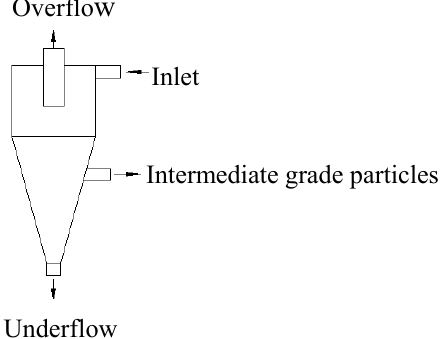
Figure 4. Three-product cyclone with double spigot.